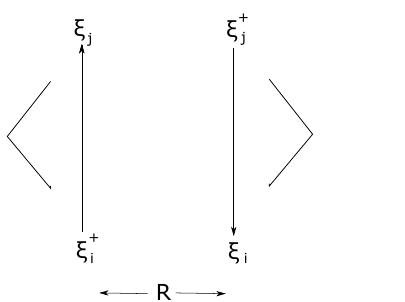
Figure 2. Schematic representation of [ T ] ji ( R ), which is a cor- relator of Wilson lines, separated by distance R , terminated at either end by pseudomatter fields, here denoted ξ i .